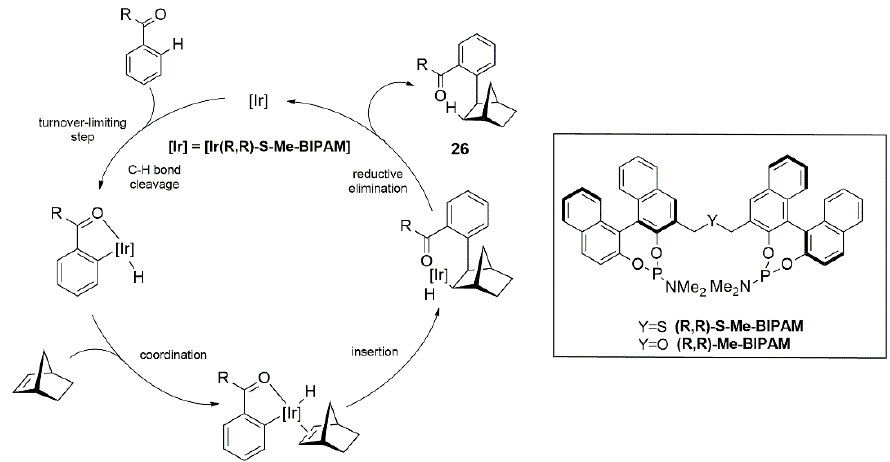
Figure 16 . Proposed mechanism for the hydroarylation of alkylated acetophenone ( 26 ) and benzamide derivatives.